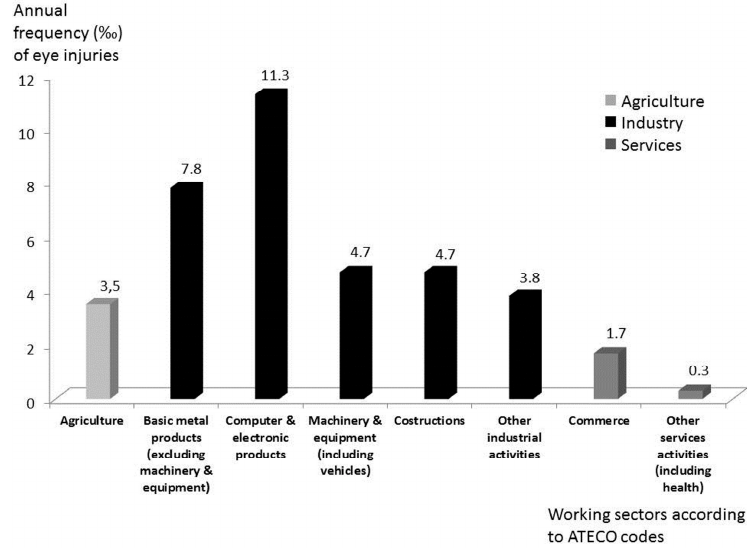
Figure 5. The annual frequency of work-related eye-injuries per 1000 workers employed in 2014 in the province of Modena, considering the main working sectors classified according to the “Attività Economiche” (ATECO) classification codes.